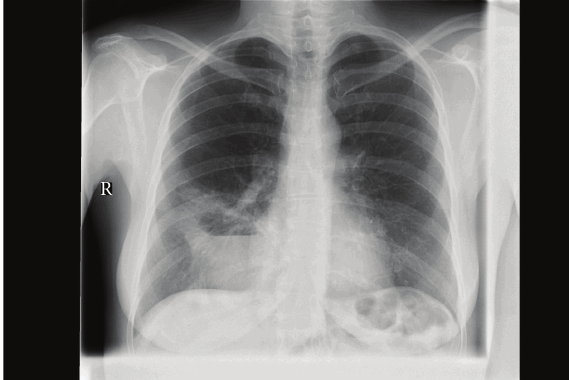
Figure 2: Abscess formation of an intralobar pulmonary sequestra- tion in right lower